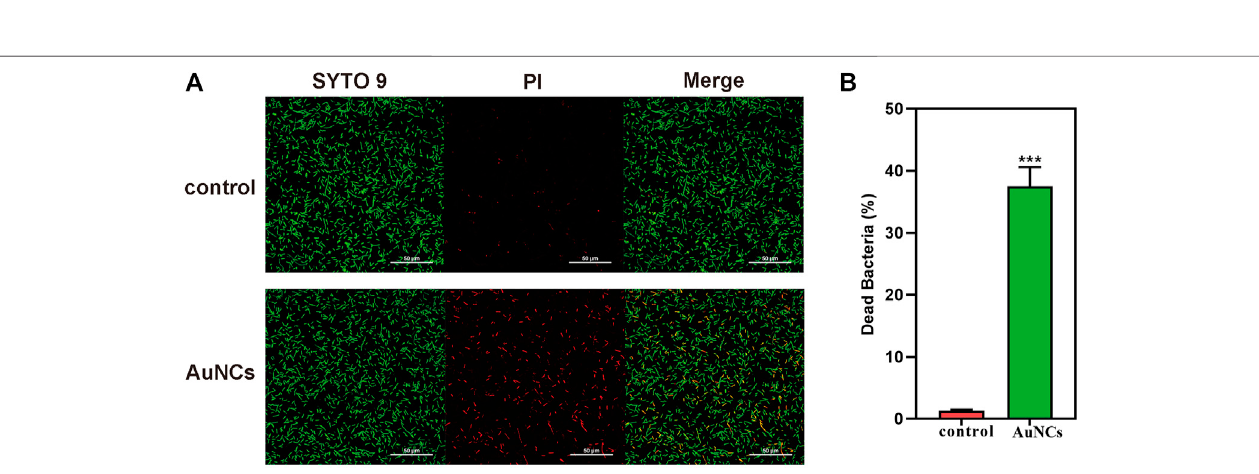
FIGURE 3 | (A) Live/dead fl uorescent staining images of F. nucleatum and (B) percentage of dead F. nucleatum after being exposed to AuNCs (0.2 mM) for 6 h (***P < 0.001).